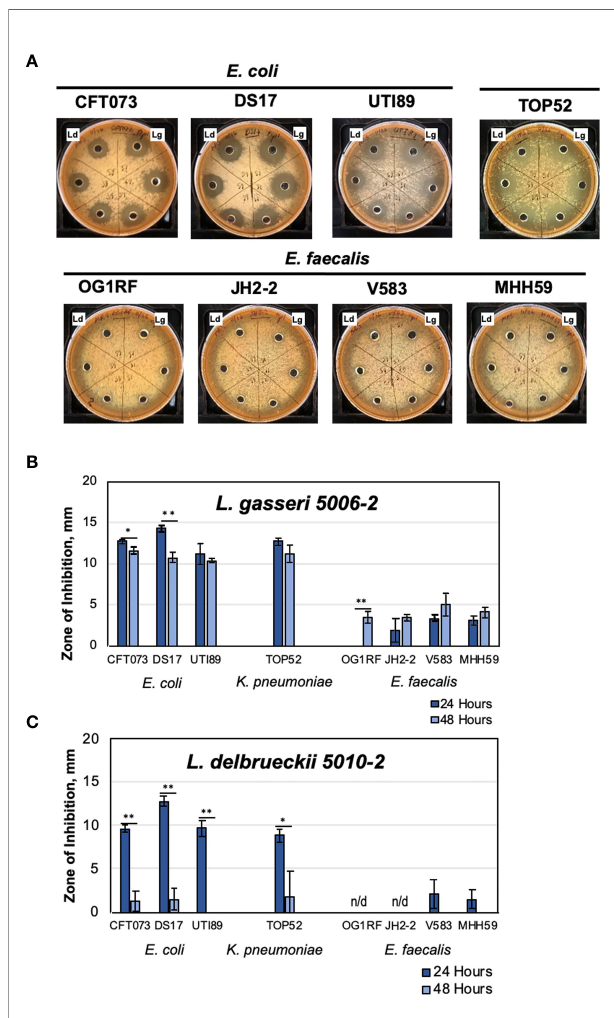
FIGURE 1 | Urinary lactobacilli L. gasseri 5006-2 and L. delbrueckii 5010-2 inhibit a broad range of uropathogens. Representative images of well-diffusion inhibition assays using E. coli, K. pneumoniae , and E. faecalis (A) , and zone of inhibition sizes of one-day old (dark blue) or two-day old (light blue) cultures of L. gasseri 5006-2 [Lg , (B) ] and L. delbrueckii 5010-2 [Ld, (C) ] against 8 pathogenic strains ( Table 2 ). Error bars indicate standard deviation of three biological replicates, *p < 0.05 and **p <